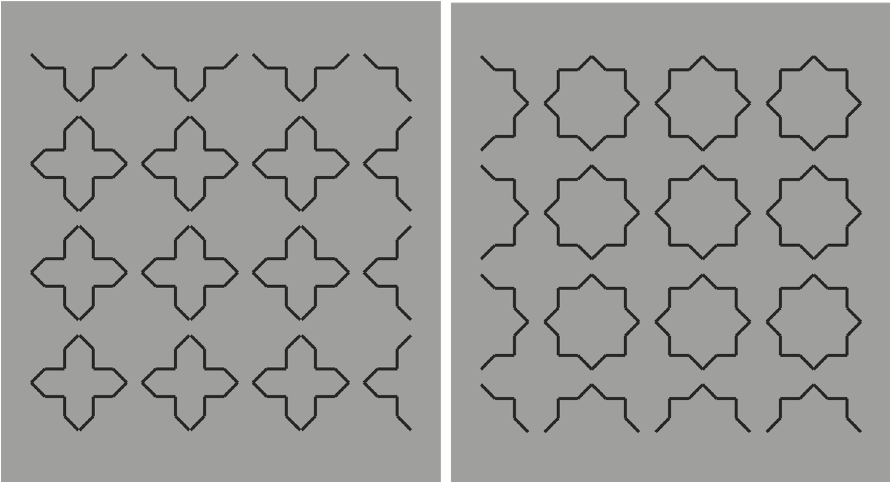
Figure 4. Crosses and stars elicited by the closure and proximity principles.